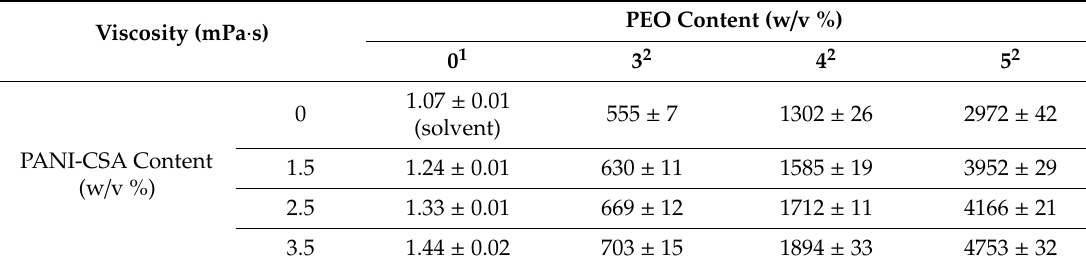
Table 1. Viscosity of polymer